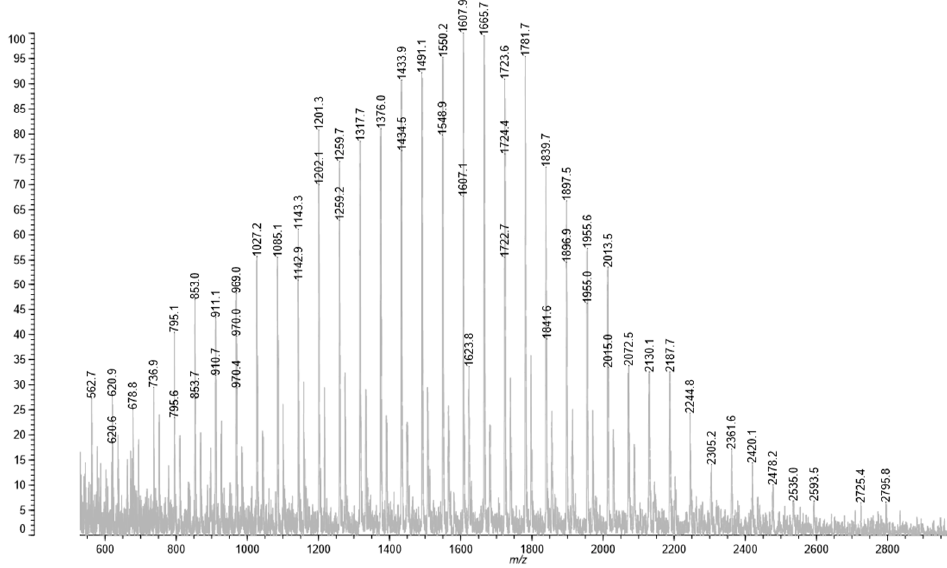
Figure 4. MALDI-TOF spectrum of PPO-diol (1) obtained with K-DPG /